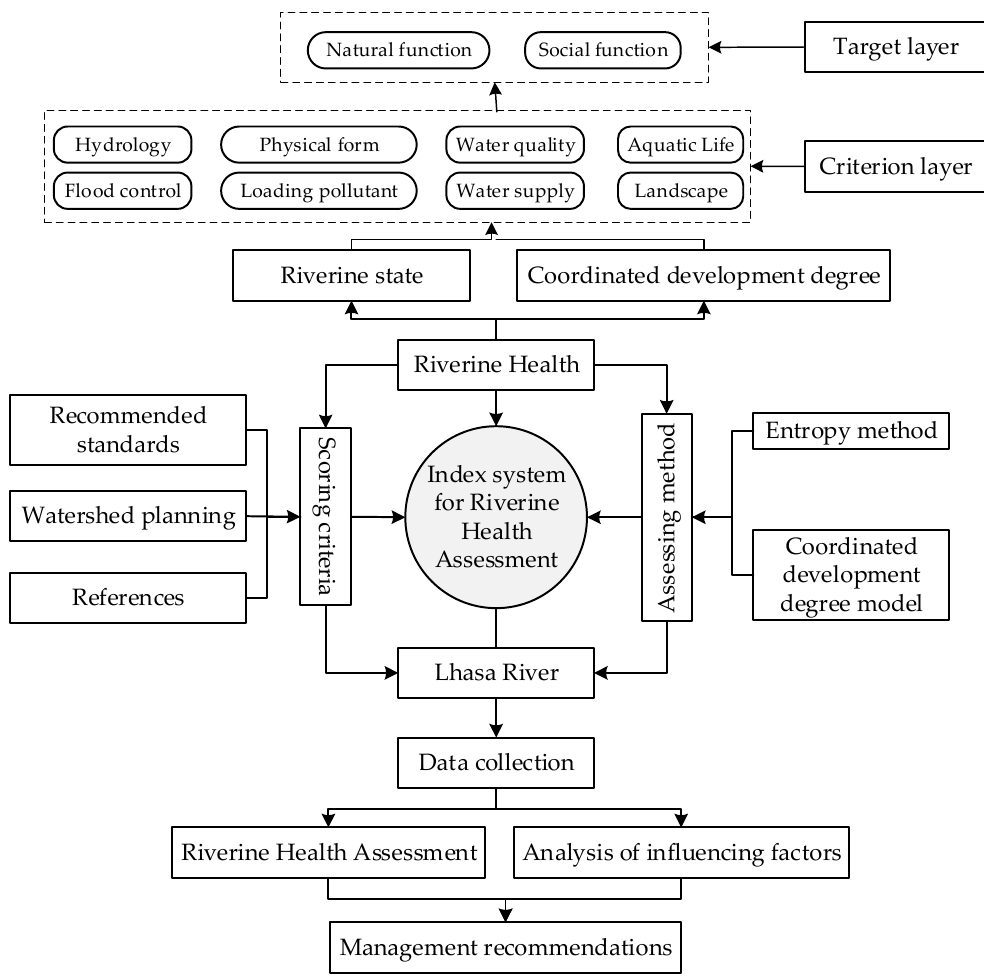
Figure 2. The overall framework of riverine health assessment index system.